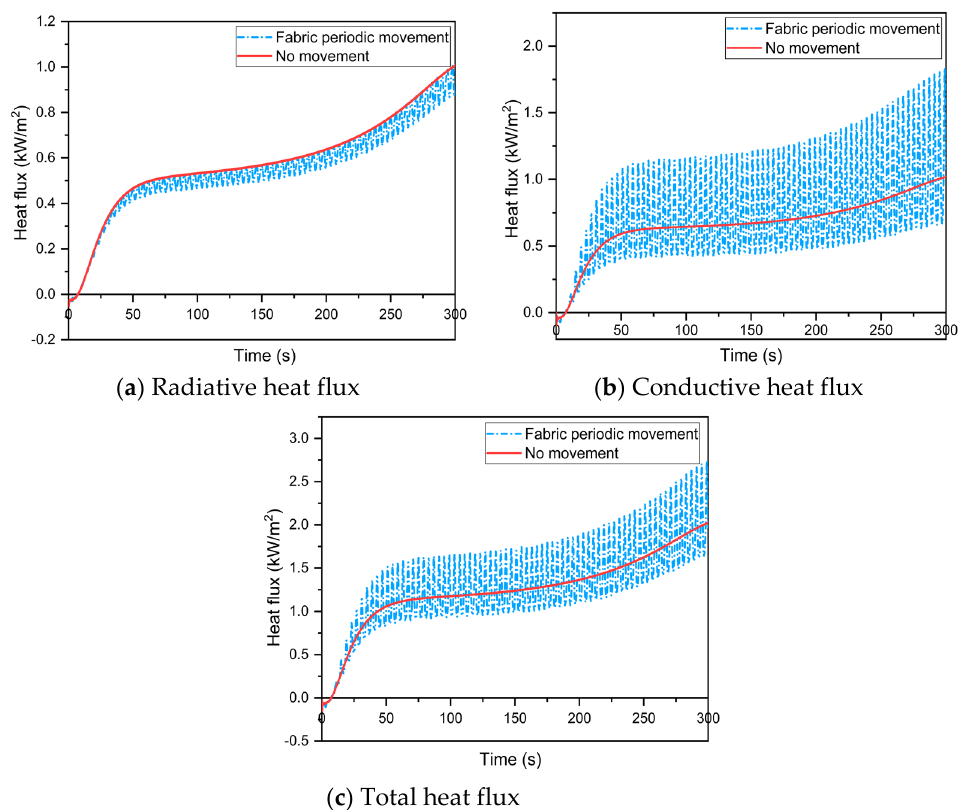
Figure 9. Effect of the fabric periodic movement on heat flux through the microenvironment between the thermal liner back surface and the skin.